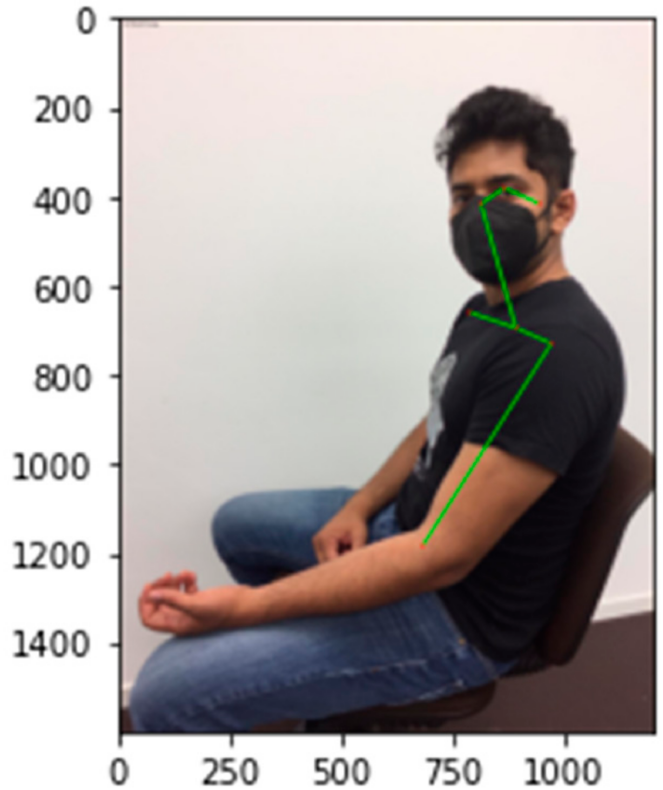
Figure 8. Predicting patients pose for injection. The algorithm that continuously processes video streams received through the front facing cameras and directs the humanoid robot to deliver an injection to COVID-19 patients is described below in Figure